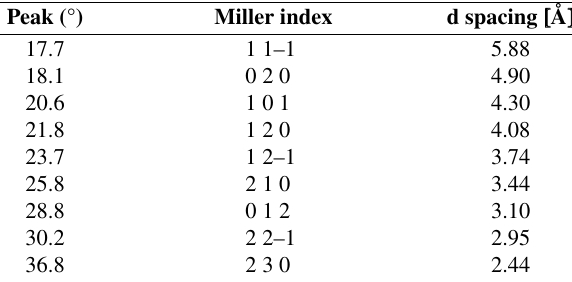
Table 2. Miller indexes and d-spacings of the synthesized zinc bo-